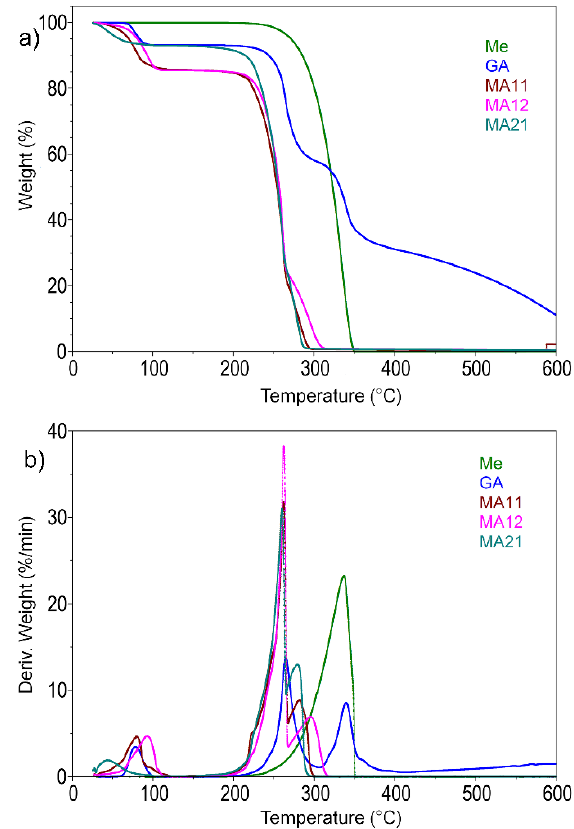
Figure 3. Thermogravimetric curves (TG) ( a ) and their derivatives (DTG) ( b ) for Me, GA, and MA complexes.